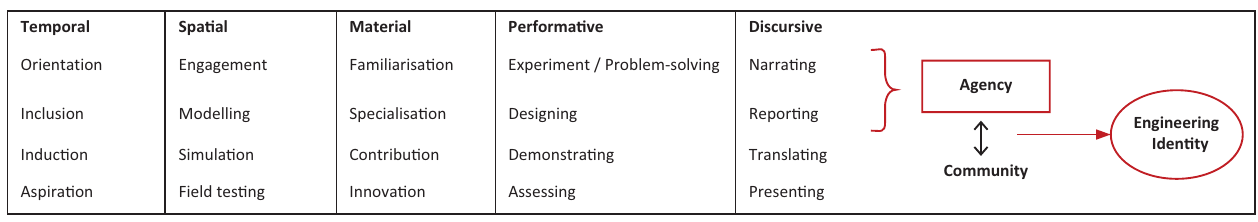
FIGURE 3: Dimensions of identity formation in engineering